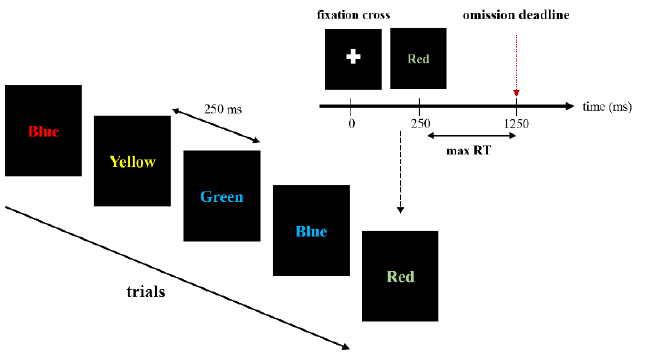
Figure 2. A typical sequence of the Stroop Color and Word Test (SCWT). max RT = maximum response time tolerated, after which the response was considered incorrect.